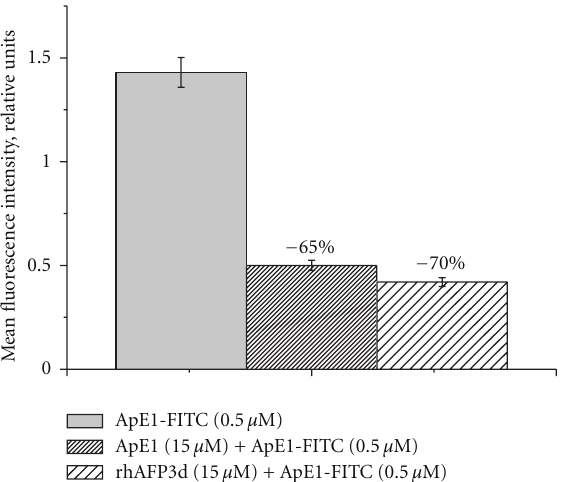
Figure 6: Inhibition of FITC-labeled ApE1 binding to MCF-7 cells in the presence of excess of free ApE1 or